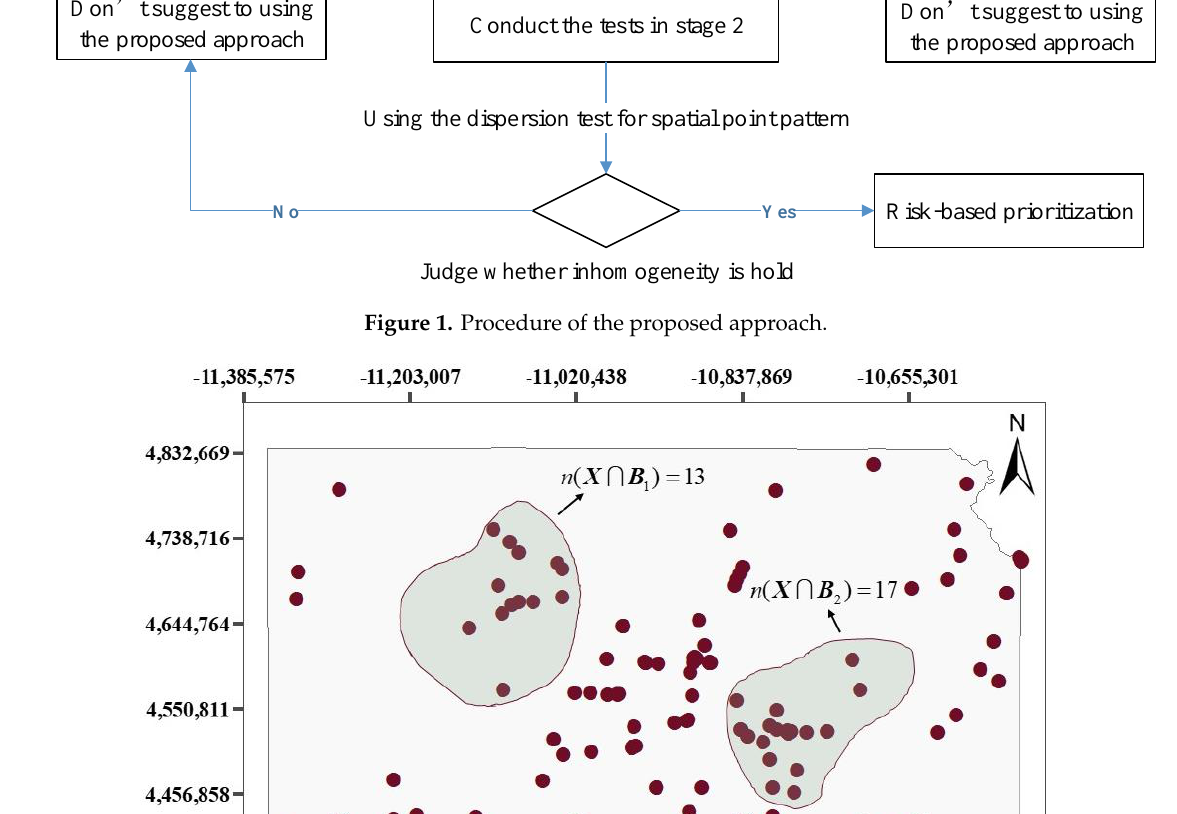
Figure 1. Procedure of the proposed approach.